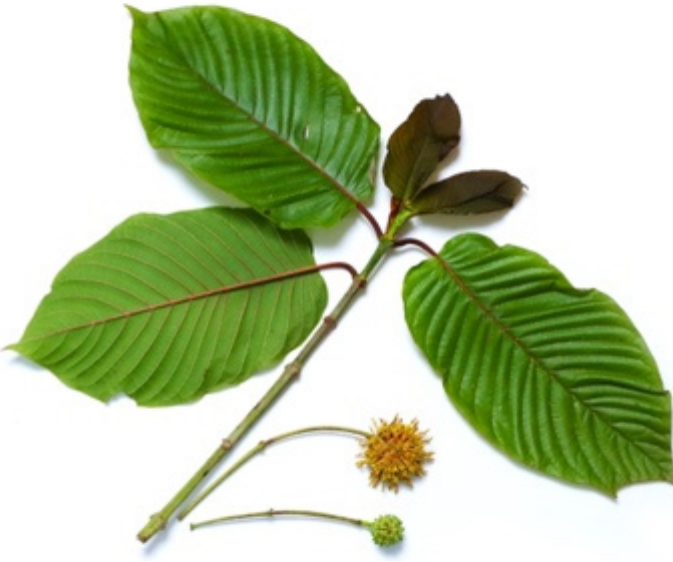
Figure 1. Mitragyna speciosa (Korth.) Havil. or Kratom.